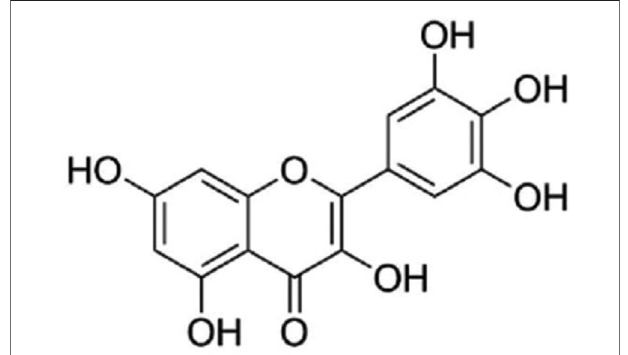
FIGURE 1 | The structure of